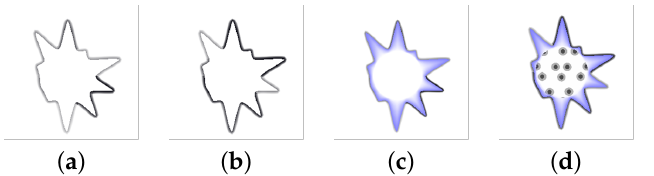
Figure 8. Asymmetry/Kurtosis visualization. ( a , b ) Boundary visualizing the variation of the asym- metry/kurtosis metric along the dimensions. ( c ) Boundary ( a ) with color emphasis. ( d ) Boundary ( a ) with